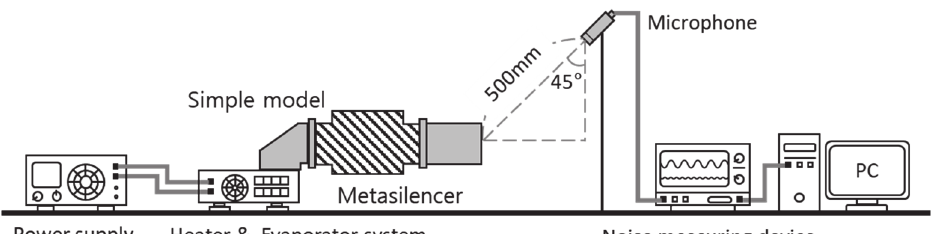
Figure 9. Schematic of speaker test setup.